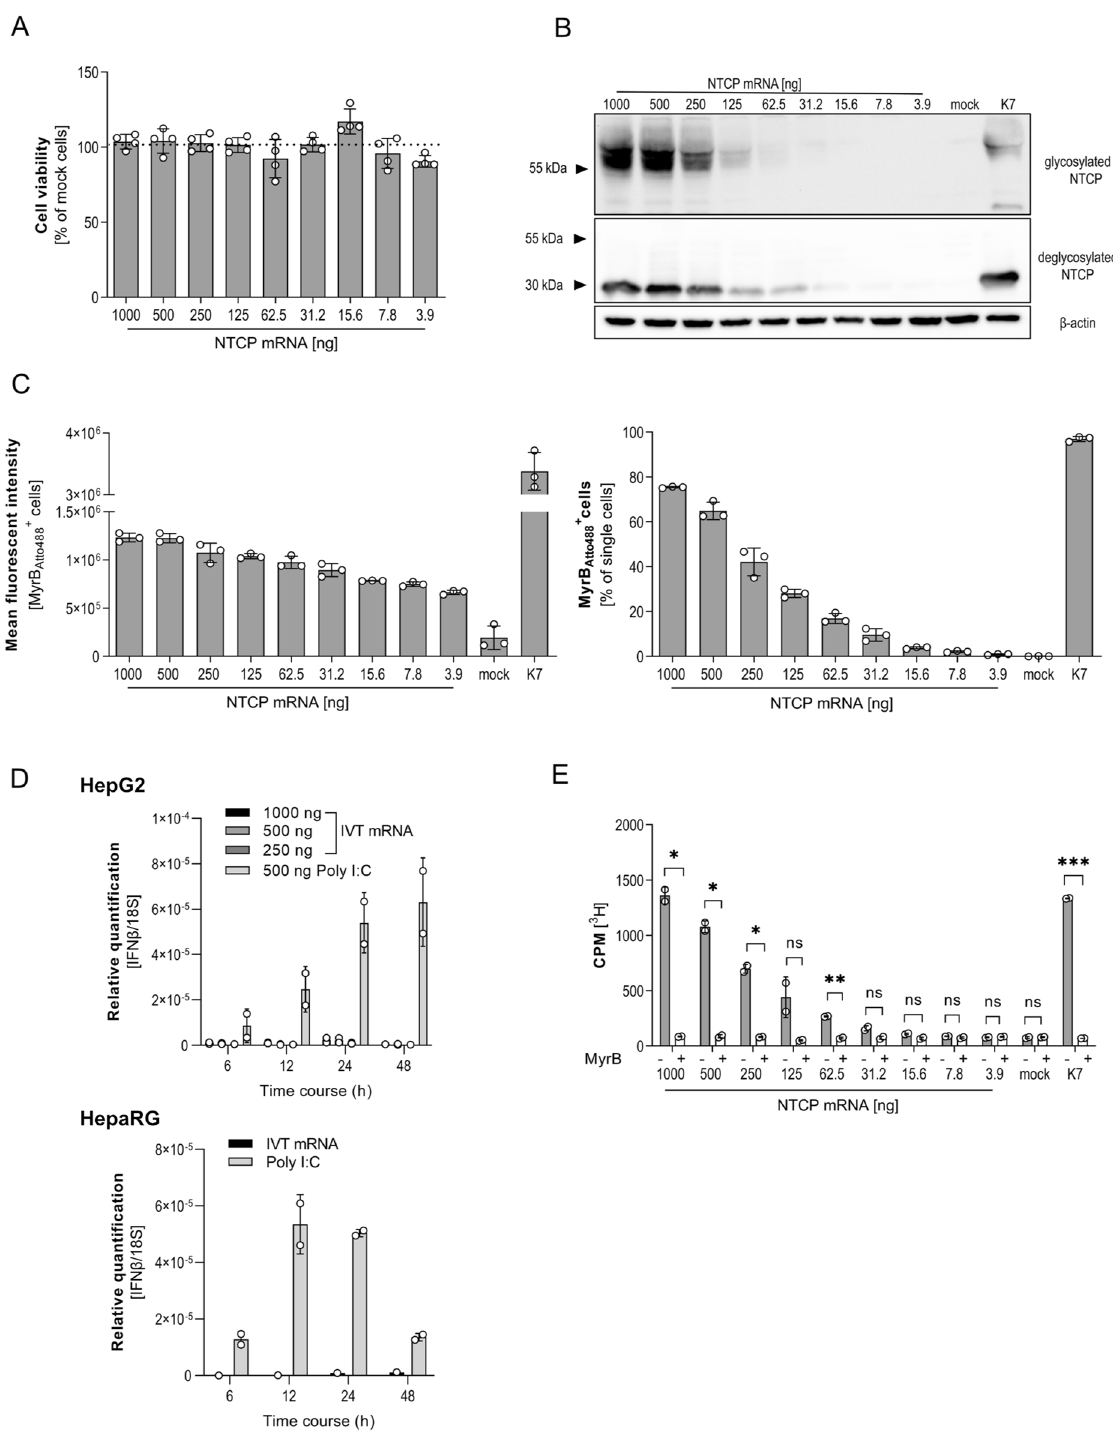
Figure 5. Expression and functionality of NTCP protein dependent on the dose of ICT mRNA. HepG2 cells were transfected with increasing amounts of IVT mRNA as indicated. ( A ) Cell viability was determined via CellTiter Blue assay 24 h post transfection. Non-transfected cells were set to 100%. ( B ) Western blot analysis of NTCP expression compared to HepG2-NTCP-K7 cell line. Glycosylated (~ 50 kDa) and deglycosylated (~ 37 kDa) proteins were analyzed. β -Actin was used as loading control. ( C ) Cells were incubated with MyrB Atto488+ to analyze binding to NTCP on the cell surface using flow cytometry, showing total NTCP + cells stained with MyrB488 (left) and calculated mean fluorescence intensity of MyrB488 + cells. ( D ) Relative quantification of time-dependent IFN β expression by qPCR after transfection of IVT mRNA and Poly I:C in HepG2 (top) and HepaRG (bottom). ( E ) [ 3 H] taurocholate was added 24 h post transfection and internalization was measured using a scintillation counter. Treatment with 200 nM MyrB served as negative control. In all experiments, mean ± SD of biological triplicates ( A , C ) or biological duplicates ( D , E ) is shown. Statistical significance was determined using Welsh corrected Student’s t test (*p < 0.05, **p < 0.01, ***p < 0.001, ****p <